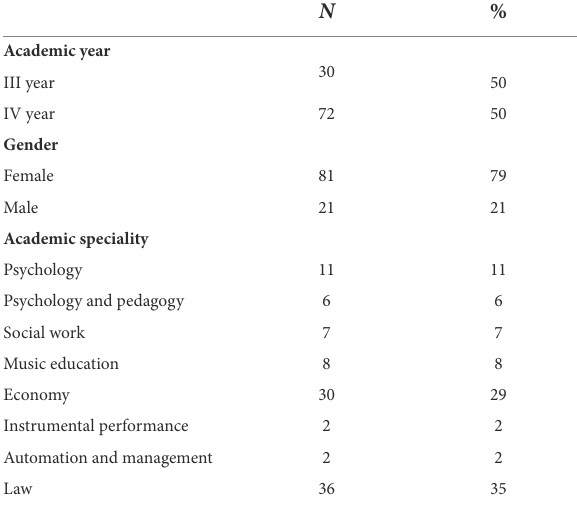
TABLE 1 Characteristics of